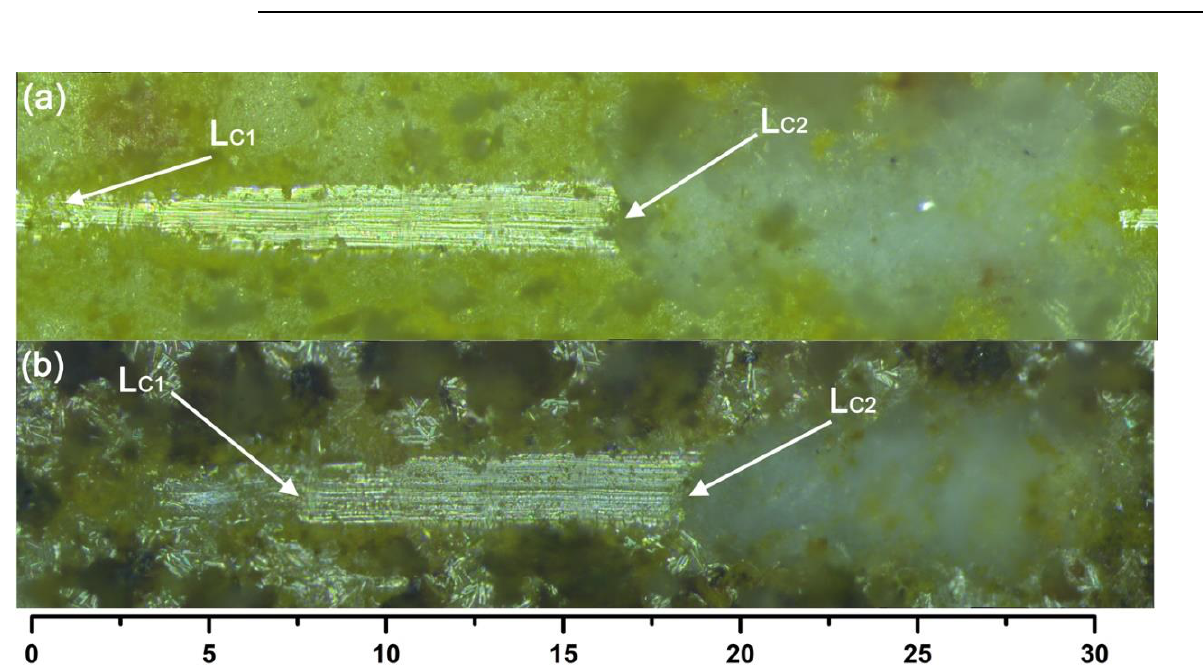
Table 1. The tape test results of functionalized ceramic tiles were sintered at different tempera- tures.